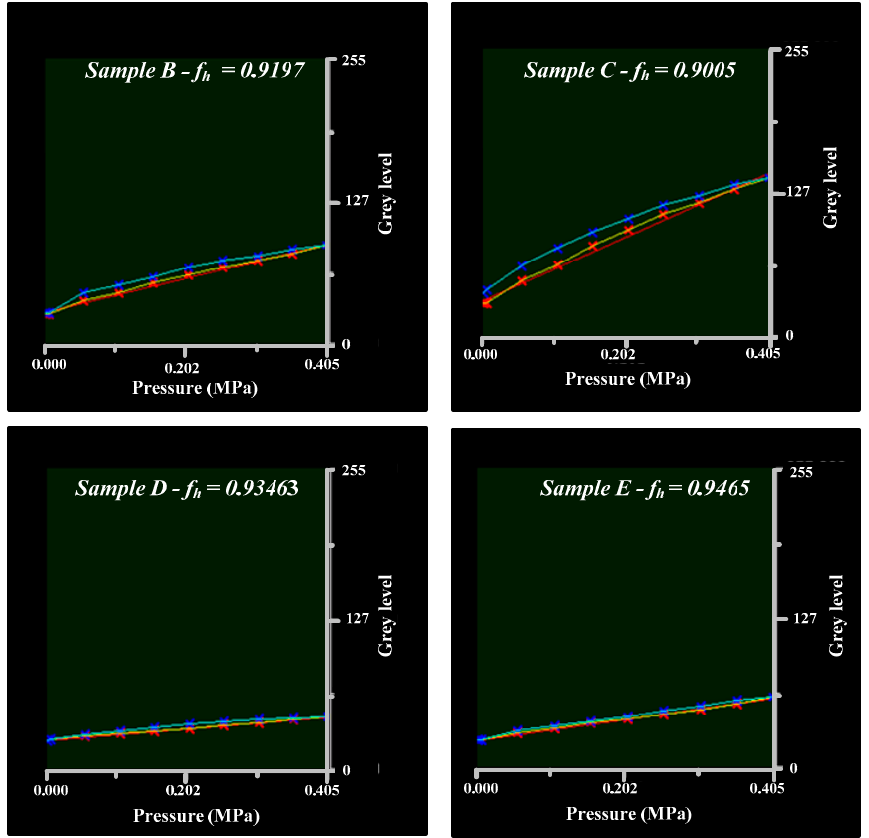
Figure 8. Hysteresis in samples B, C, D and E.